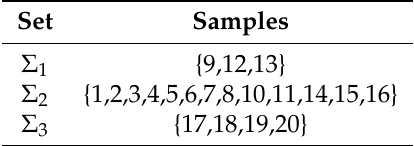
Table A4. Obtained subsets when partitioning the training set at iteration i =